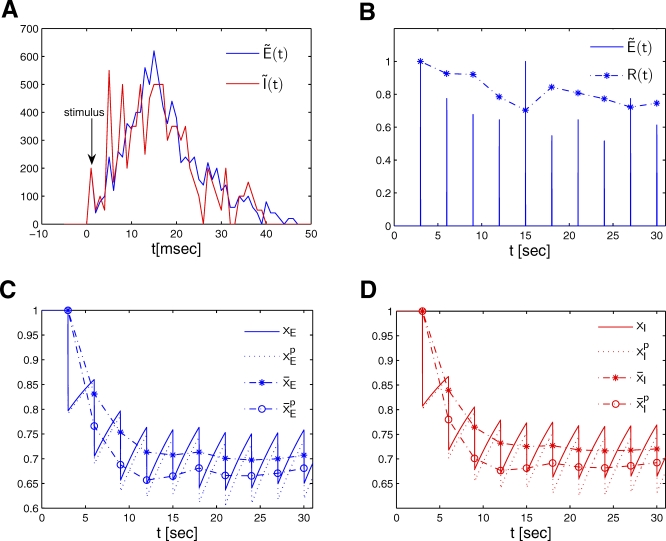
Single Site Stimulation in a Simulated NetworkThe simulation model consisted of a network of leaky integrate and fire neurons with depressing synapses, as described in Materials and Methods.(A) The network is stimulated every 3 s to produce a transient response of both the inhibitory and the excitatory subnetworks.(B) The network adapts to the stimulus and the total responsiveness (as defined in Equation 3) declines.(C, D) Comparing the slow depression variables, averaged over the populations, xE and xI, and the value predicted from the network's activity,
and
(using Equation 20), where
and
are the activities obtained from the simulation), validates our assumptions for averaging over neural ensembles. Furthermore, the time-averaged variables
and their predicted value
(calculated from the averaged network's activity using Equation 7), where E and I are the integrated activity obtained from the simulation) converge to a similar steady-state value, which validates our assumptions for averaging over the stimulation period.